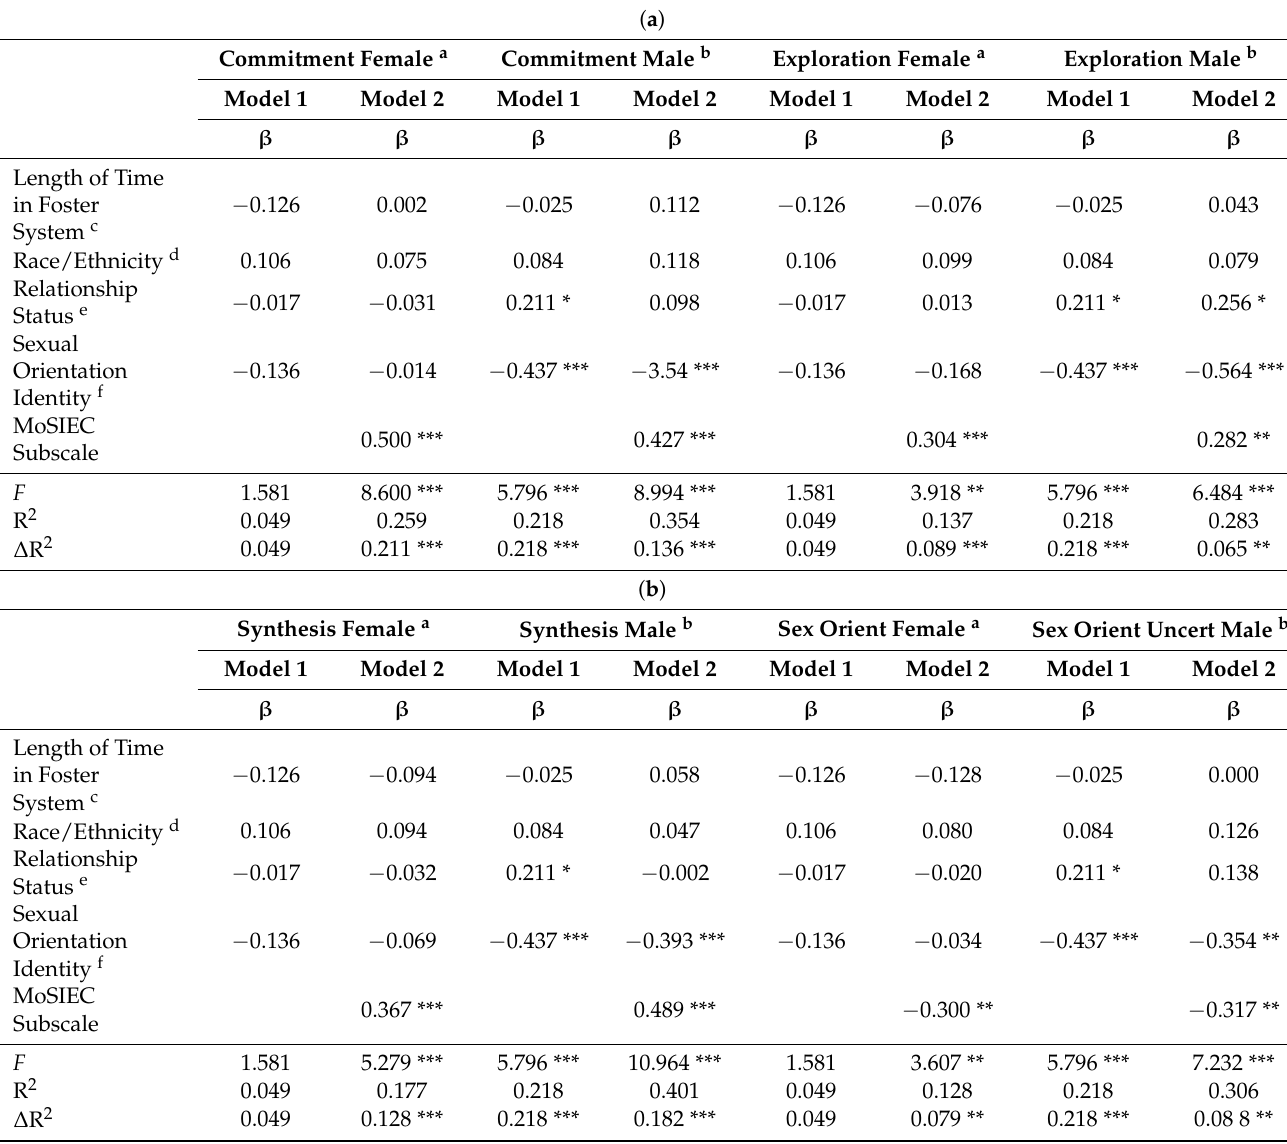
Table 4. (a) Results of Hierarchical Multiple Regression for MoSIEC Subscales on Sexual Well-being. (b) Results of Hierarchical Multiple Regression for MoSIEC Commitment Subscale a . ( a